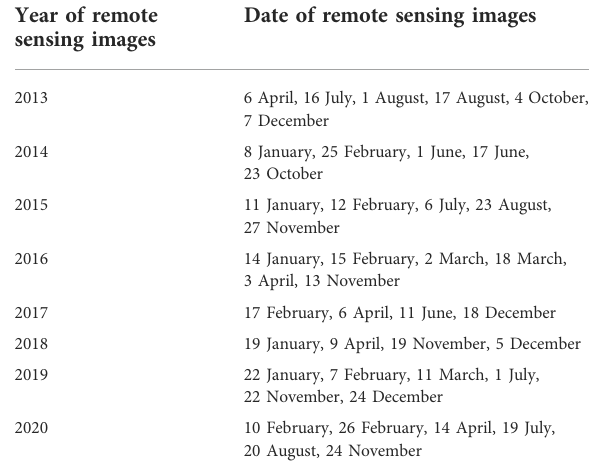
TABLE 3 Date of remote sensing images. Year of remote sensing images